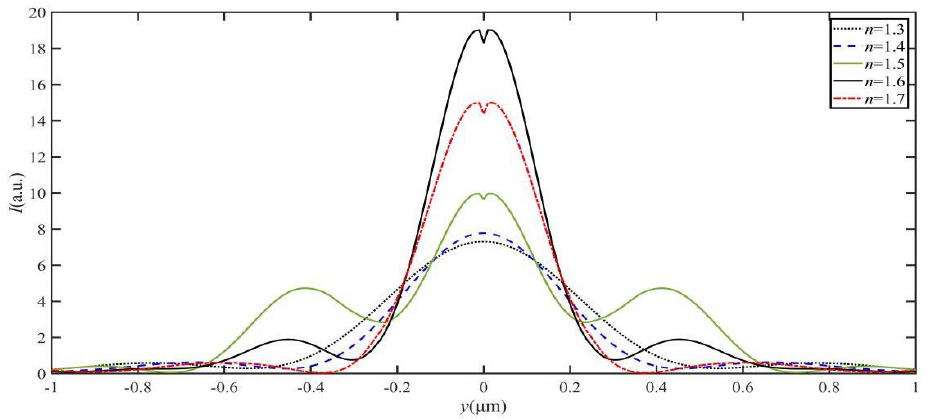
Figure 6. Comparison of full width at half maximum F of the SPP-PNJ with different dielectric microdisk refractive indices n .